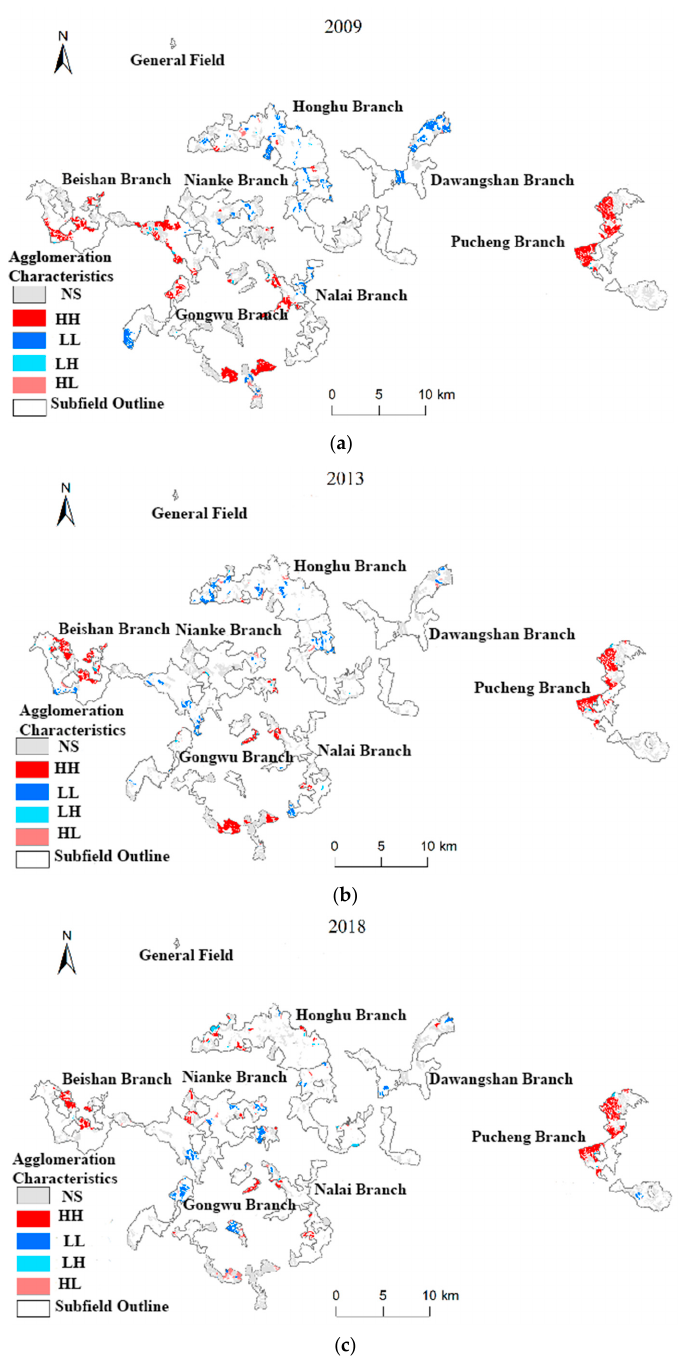
Figure 4. This is a Local LISA plot that shows the relationship between wood supply and carbon sequestration and oxygen release services in the PM plantations of Guangxi Paiyangshan Forest Farm from 2009 to 2018. The analysis used the following indicators: NS (not signi fi cantly clustered), HH (high–high clustering), LL (low–low agglomeration), LH (low–high agglomeration), HL (high– low agglomeration). The plot includes the following LISA maps: ( a ) wood supply and carbon se- questration and oxygen release services in 2009; ( b ) wood supply and carbon sequestration and oxygen release services in 2013; and ( c ) wood supply and carbon sequestration and oxygen release services in 2018. From 2009 to 2018, the synergistic and trade-o ff areas between wood supply and wa- ter conservation were more synergistic than trade-o ff areas (Figure 5). In 2009, the areas of synergistic enhancement were mainly located in the southern Gongwu branch and the western and eastern parts of the Pucheng branch. However, the synergistic enhancement area signi fi cantly reduced in 2013, particularly in the Gongwu branch. In 2018, the syner- gistic enhancement area of the Pucheng branch decreased while the southern Gongwu and Beishan branches saw a signi fi cant increase. Conversely, the areas where the synergy weakened in 2009 were mainly concentrated in the Honghu branch, Nianke branch, the northwestern part of the Nalai branch, and the Dawangshan branch. This area signi fi - cantly reduced in 2013 and only remained in the Beishan branch, southwestern part of